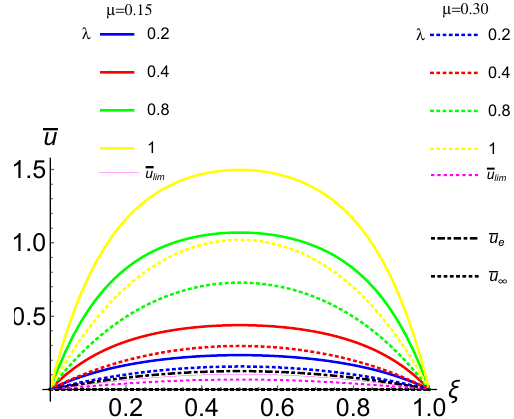
Figure 9. CC nano-rod subject to a uniformly distributed axial load. Plot of the non-dimensional axial displacement ¯ u , limit non-dimensional axial displacement ¯ u ∞ (black dotted line) and local non-dimensional axial displacement ¯ u e (black dot dashed line) vs. the nano-rod non-dimensional length ξ in terms of the nonlocal non-dimensional parameter λ in the set { 0.2,0.4,0.8,1.0 } and gradient non-dimensional parameter µ in the set { 0.15,0.30 }